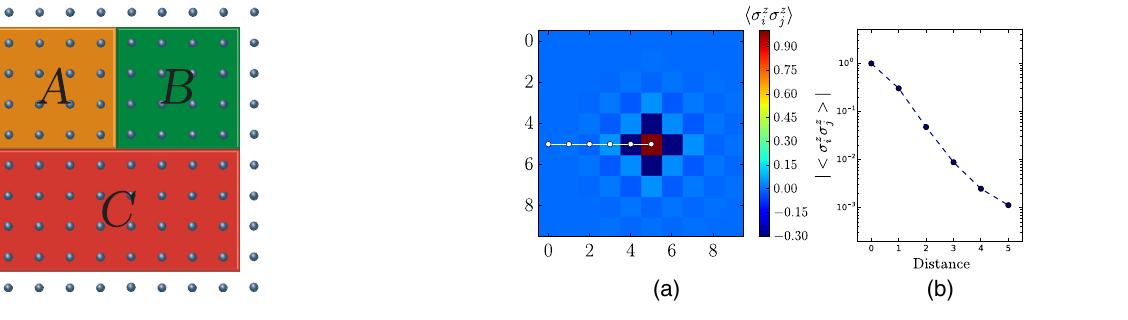
FIG. 7. (a) The spin-spin correlation function between one lattice site (in red) and all other spins on the lattice measured on the optimized l-RBM with lowest energy reveals the antiferro- magnetic behavior of the correlations. (b) Decay of the corre- lations with the distance across the direction indicated in (a) as a white solid line. The error bars are within dot size, and finite-size effects can already be seen for the last